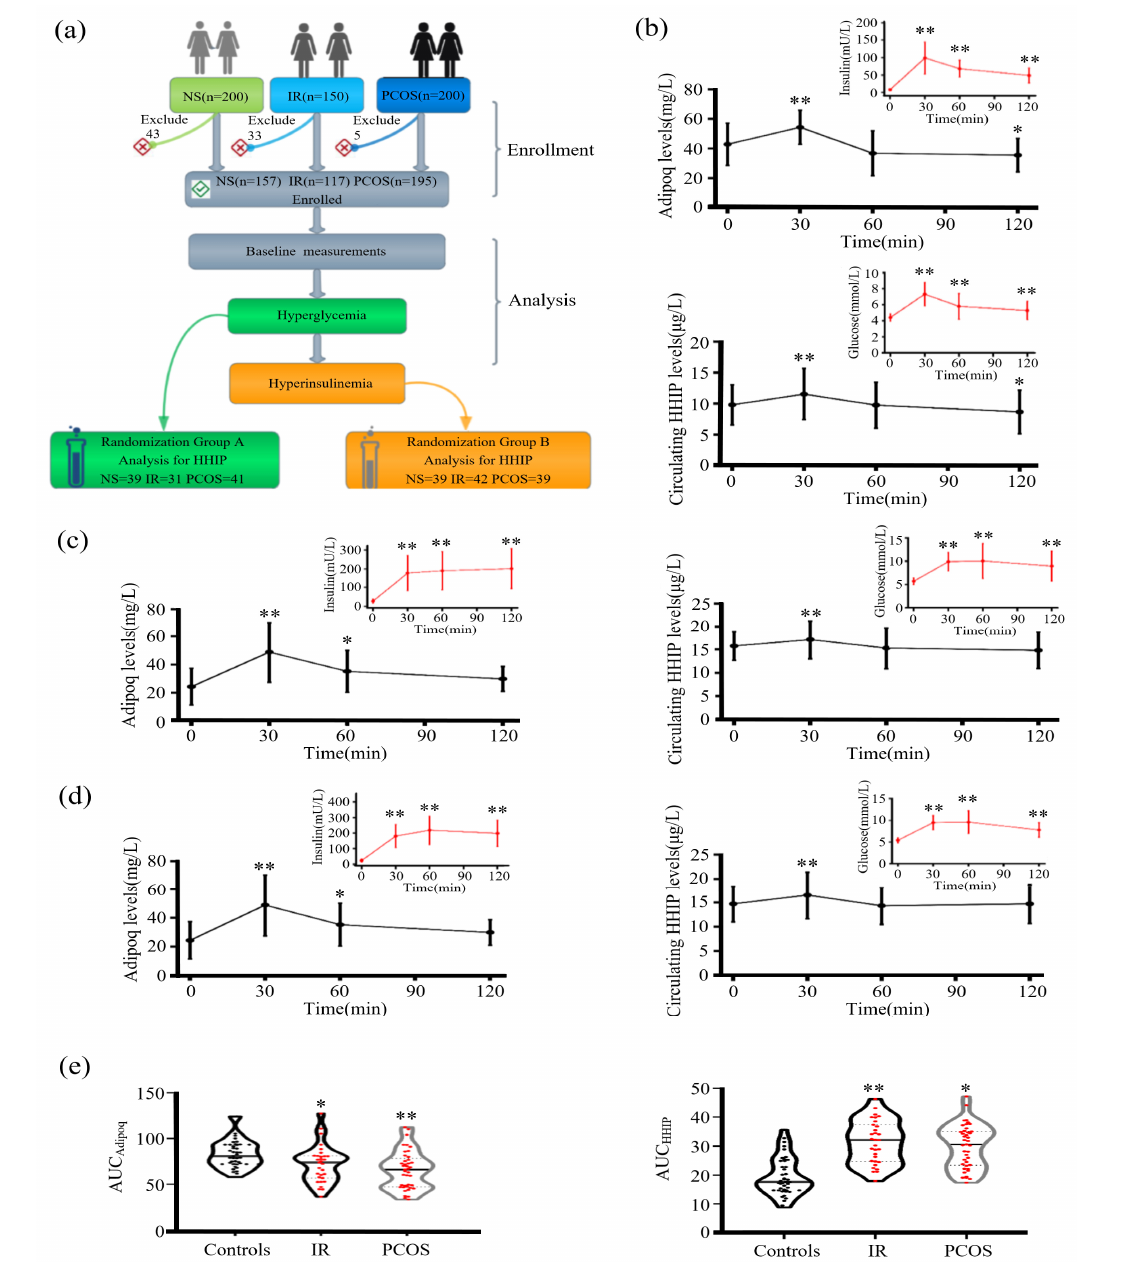
Figure 3. Serum HHIP levels in the study population during the OGTT. ( a ) Experimental design for the cross-sectional study. ( b – d ) Time course of serum HHIP and adipoq changes during the OGTT in control ( b ), IR ( c ) and PCOS ( d ) women. ( e ) AUC HHIP and AUC adipoq during the OGTT in the study population. Data are expressed as mean ± SD or median (Interquartile Range). * p < 0.05, ** p < 0.01 vs. baseline controls.